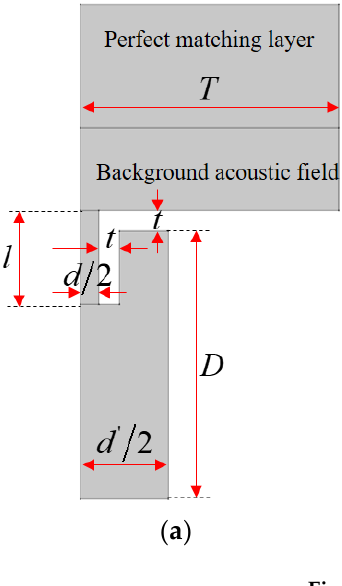
Figure 3. Two − dimensional equivalent simulation model for the single resonator in paral- lel − connection square Helmholtz resonators: ( a ) geometric model; ( b ) finite element mesh model; ( c ) sound pressure distribution.